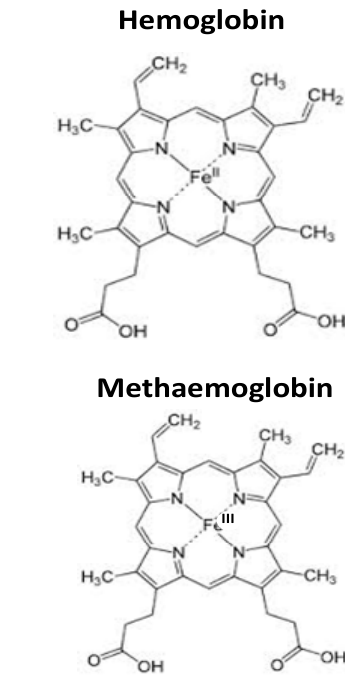
Figure 2. Methaemoglobin (MetHb) formation pathways. The nitrite (NO hemoglobin (Hb), and produces nitrogen oxide (NO) and MetHb. The NO can react with deoxyhemoglobin (HbO can produce MetHb and NO